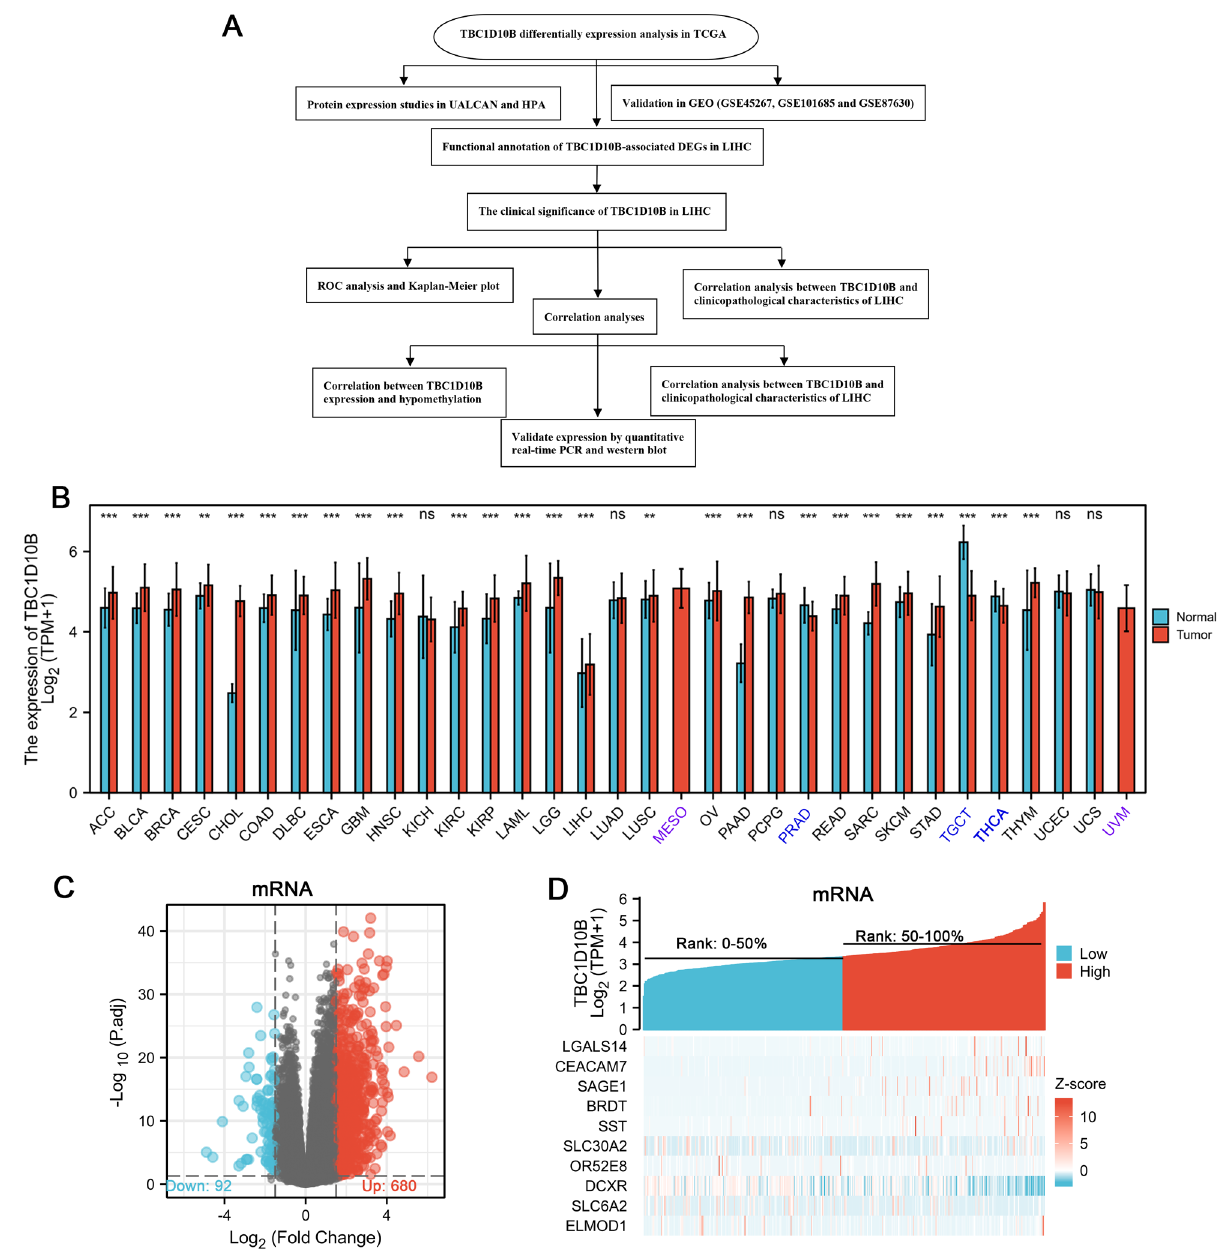
Figure 1. Differential mRNA expression profiles in liver hepatocellular carcinoma (LIHC) patients. ( A ) Flow chart of the study. ( B) Expression level of TBC1D10C gene in 33 types of tumors. Volcano plots ( C ) and a heat map ( D ) depicting the mRNA expression profiles are shown. Differentially expressed genes that are up- or downregulated at least 1.5-fold. ns, P > 0.05; ** P < 0.01; *** P <